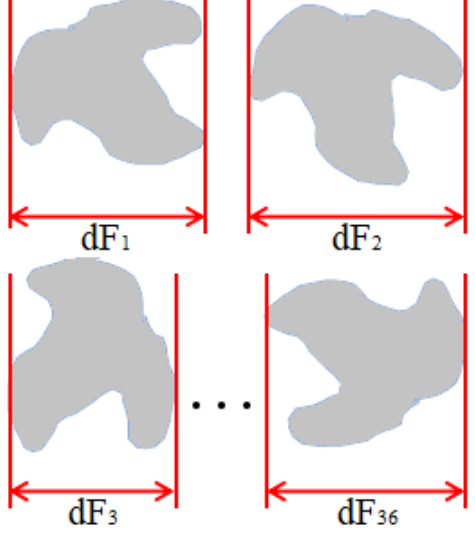
Figure 2. Feret diameter calculating process.